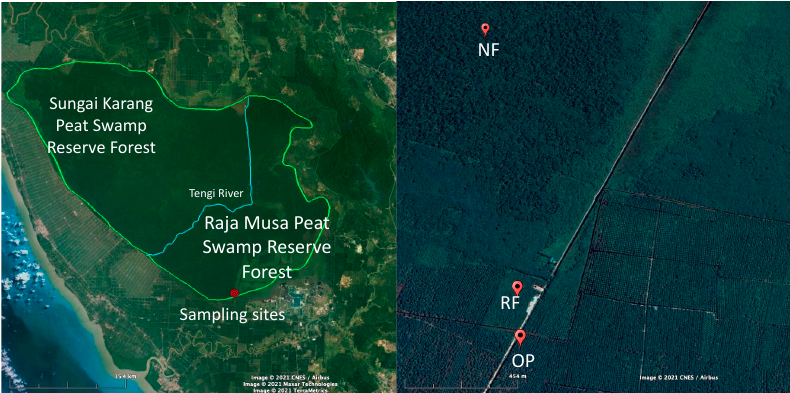
Figure 1. Study sites at Raja Musa Peat Swamp Forest Reserve. OP: oil palm plantation, RF: rewetting-restored forest and NF: natural forest.